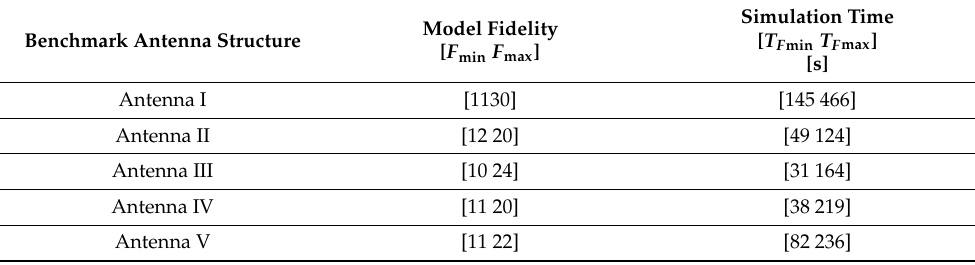
Table 2. Antenna simulation time vs. model fidelity.